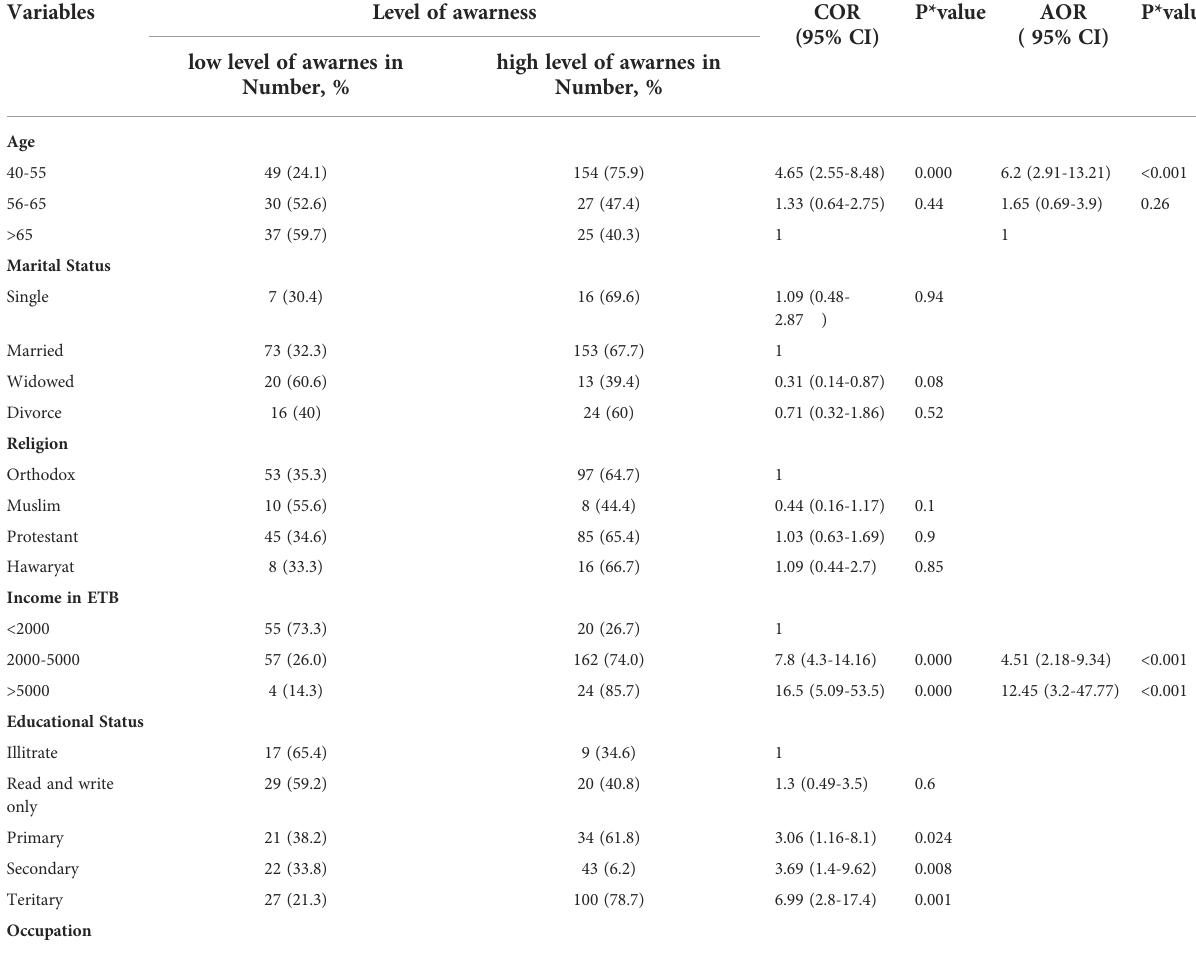
TABLE 3 Awareness questions about prostate cancer in men 40 years of age and older in Mizan Aman town, Bench Sheko zone in SNNPR, South West Ethiopia, 2019. Awareness questions Yes, n (%) No, n (%) Prostate cancer is a common malignancy. The risk of prostate cancer increases with age. Is it important to be screened for prostate cancer? DRE and PSA tests are used for prostate cancer screening or diagnosis. Dif fi culty in micturition is a complaint of prostate cancer. Prostate cancer is curable. Prostate cancer is a preventable disease. Physically inactive people are at risk of prostate cancer. Prostate cancer can cause death. Drinking alcohol is a risk factor for prostate cancer. A high-fat diet is a risk factor for prostate cancer. Smoking is a risk factor for prostate cancer.